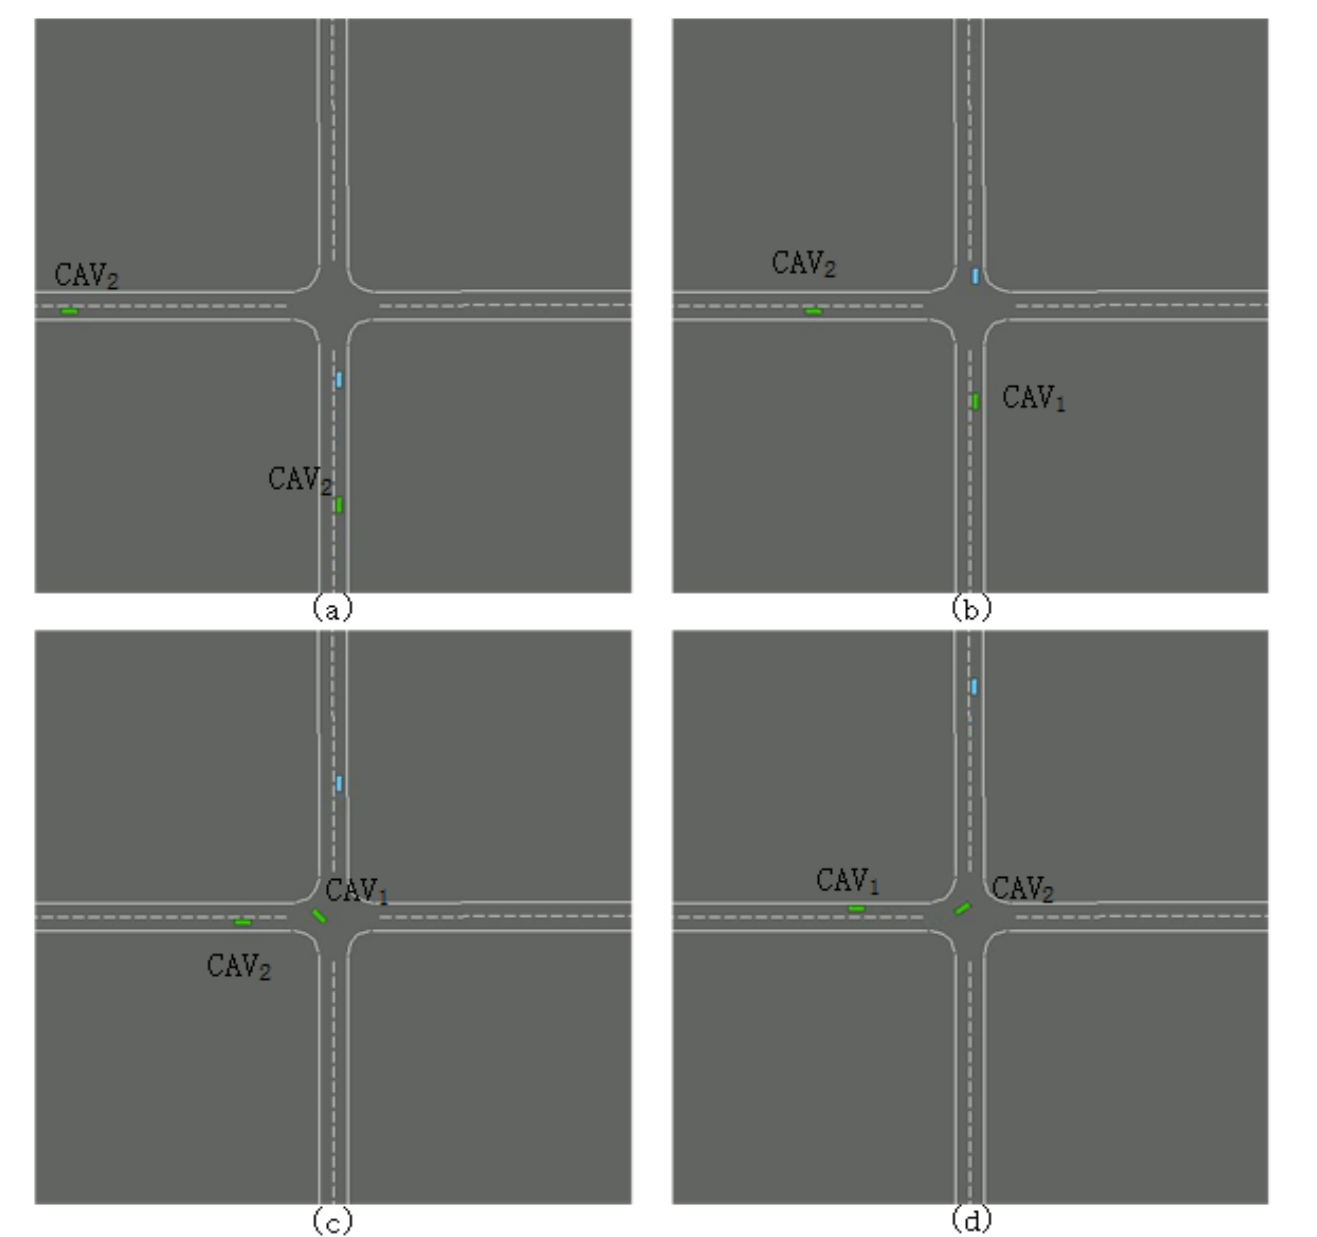
Figure 7. The frames of the time slices showing the interactions performed by the simulation platform (blue: HDV; green: CAVs); ( a ) 9 s, ( b ) 12 s, ( c ) 15 s, and ( d ) 18 s. To validate the performance of the proposed reward assignment scheme, the global reward, local reward, and the proposed weighted reward scheme were used for the training in the simple setting, i.e., the two CAVs and three HDVs. As many people are aware, collisions are more likely to occur in the areas within the intersections than in the straight lanes. When the system was penalized, the vehicle nearest the intersection should have been assigned more penalties to help it execute the correct decision. The same went for receiving a reward. The results are shown in Figure 8. As excepted, the results confirmed that the proposed weighted assignment outperformed the other two assignment